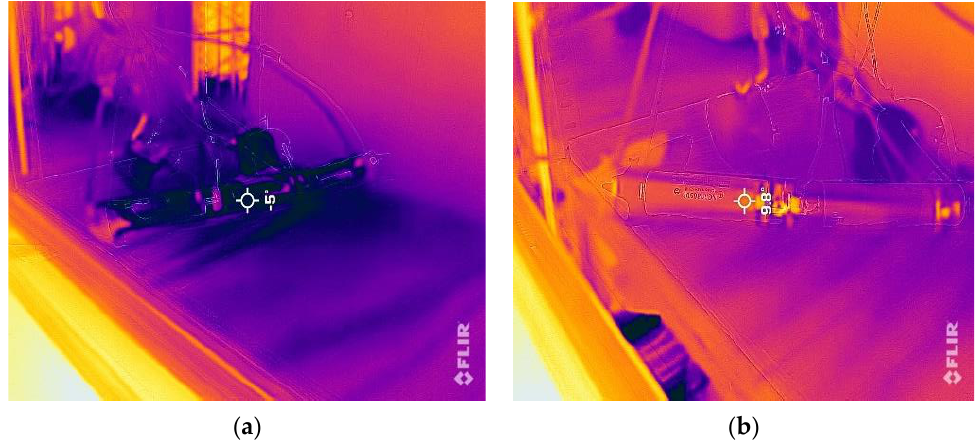
Figure 13. Thermal image inside the thermal chamber; ( a ) before the preheating at −5 °C; ( b ) after the preheating at 10 °C.